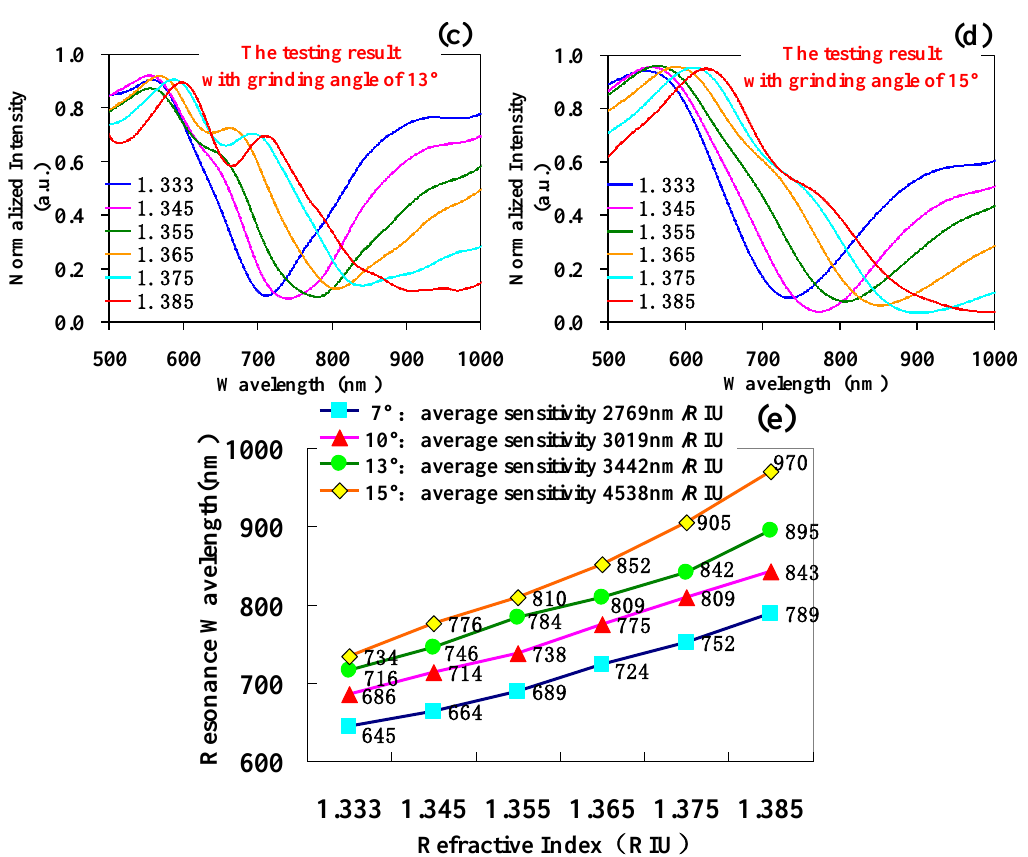
Figure 5. The SPR test results with grinding angles of ( a ) 7°, ( b ) 10°, ( c ) 13°, and ( d ) 15°. ( e ) The corresponding resonance wavelength and the average sensitivity of different grinding angles under the detection range of the same refractive index.